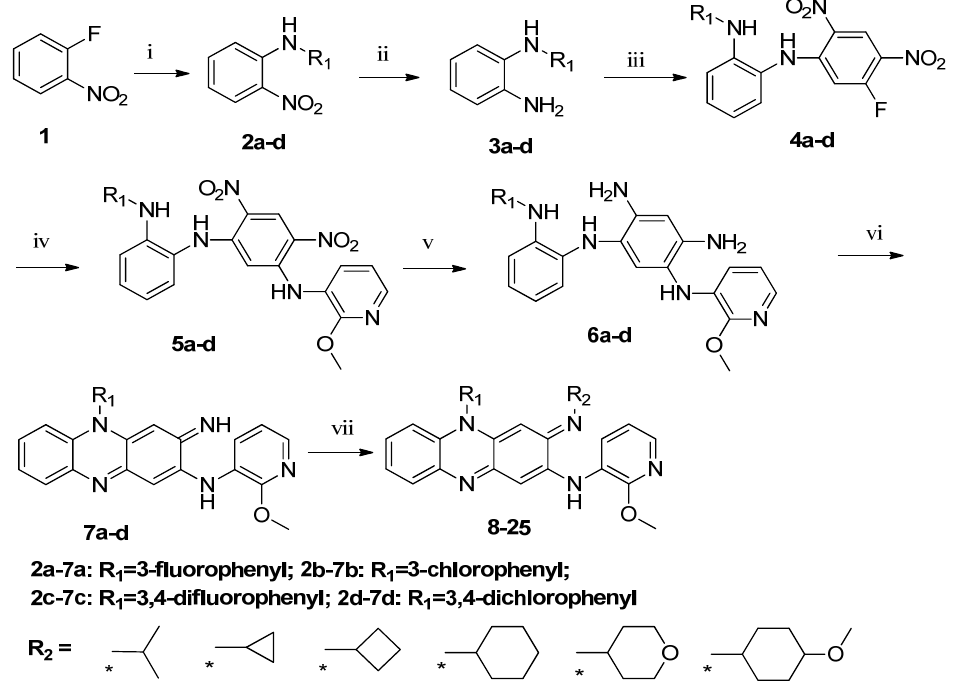
Scheme 1. Synthesis of the target compounds 8 – 25